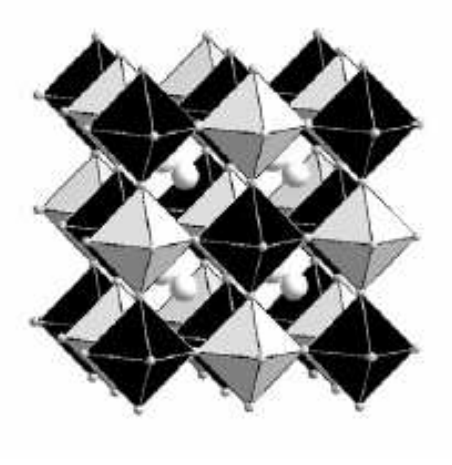
Fig. 1 Crystal structure of an ordered double perovskite with general formula A 2 BB ′ O 6